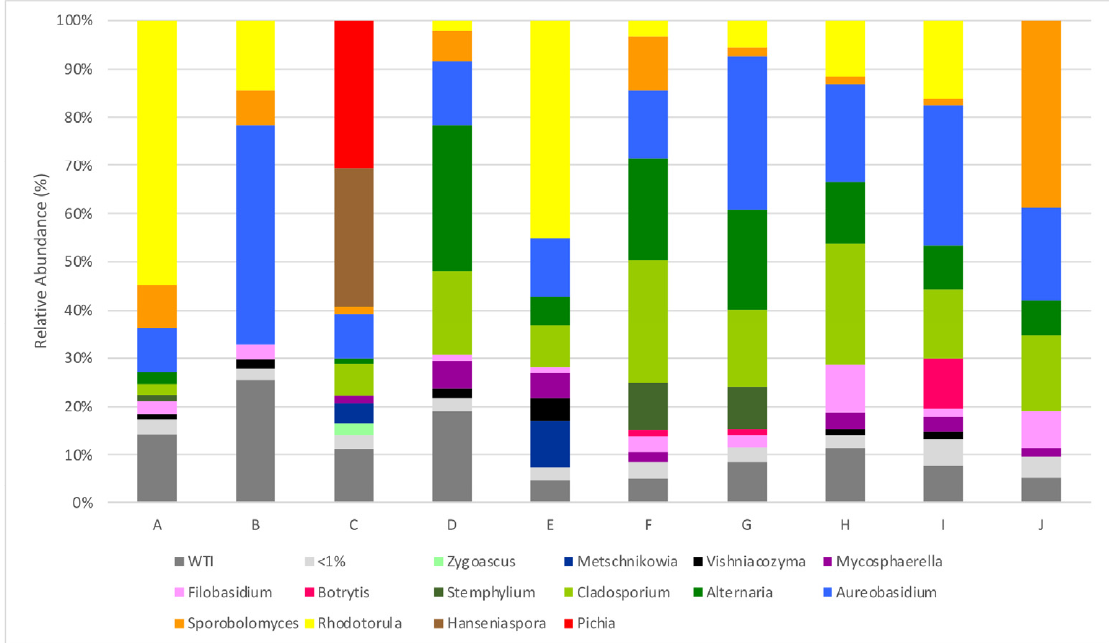
Figure 2. Relative abundances (%) of dominant sequences (>1%) assigned to genus level that were identified in samples based on partial sequence analysis of the Internal Transcribed Spacer 2 regions of the rRNA gene. WTI refers to the percentage of sequences without taxonomic attribution to the specified taxonomic level. A–J refers to the origin of the sequenced sample, as described in Table 1.